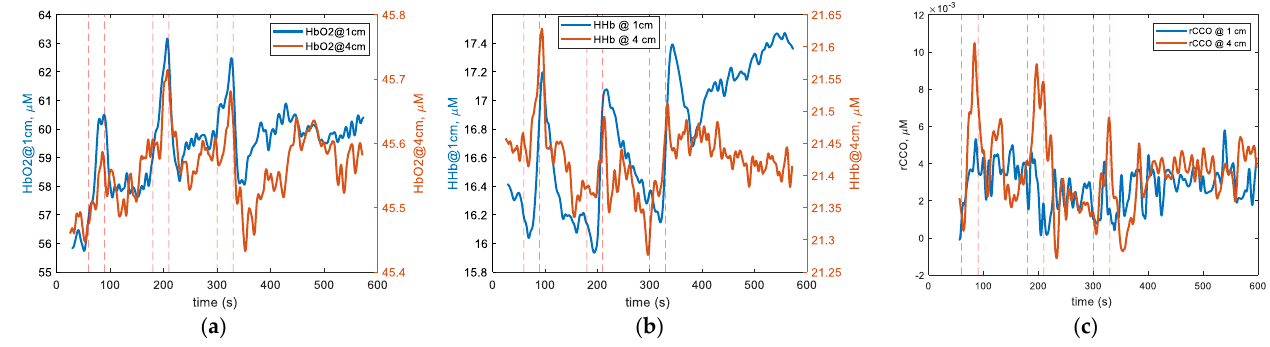
Figure 5. Cross-subject averaged temporal traces of [HbO 2 ] ( a ), [HHb] ( b ), and [rCCO] ( c ) showing a comparison of 1 cm and 4 cm time-courses and a return to the baseline 4 min after BHs.